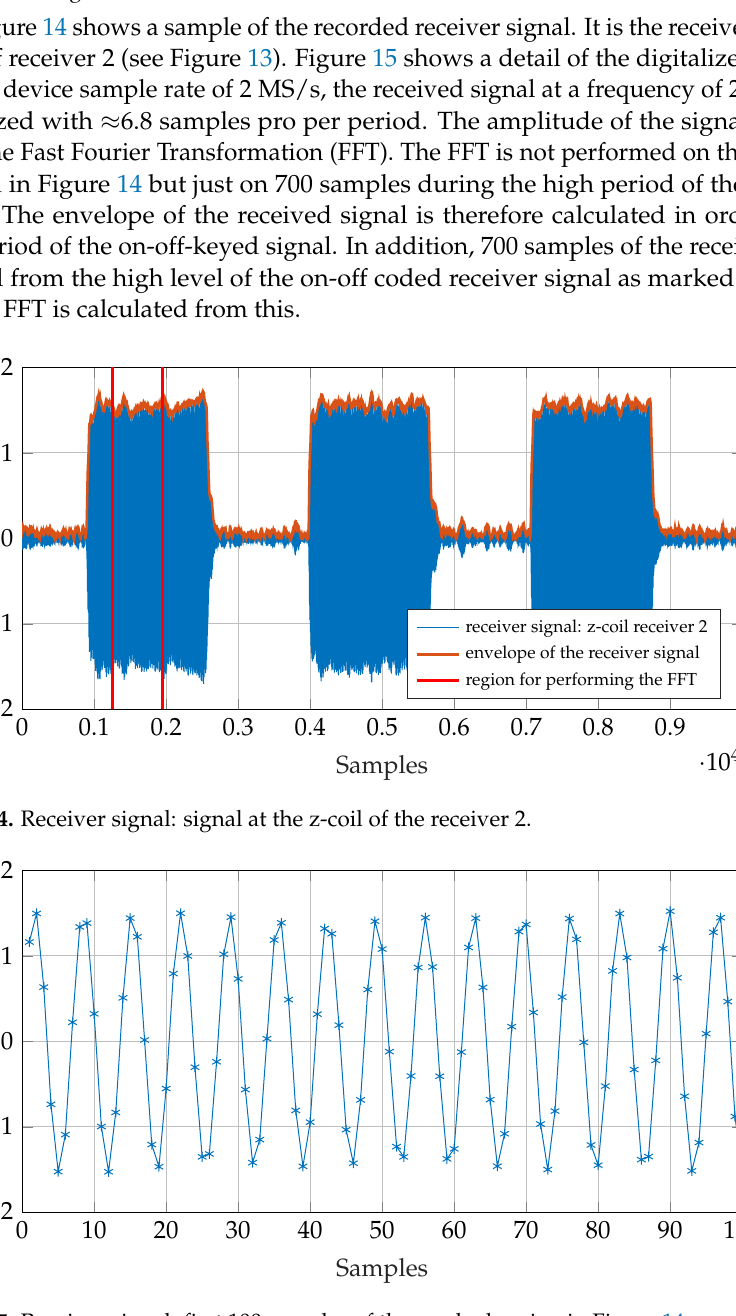
calculated receiver signal